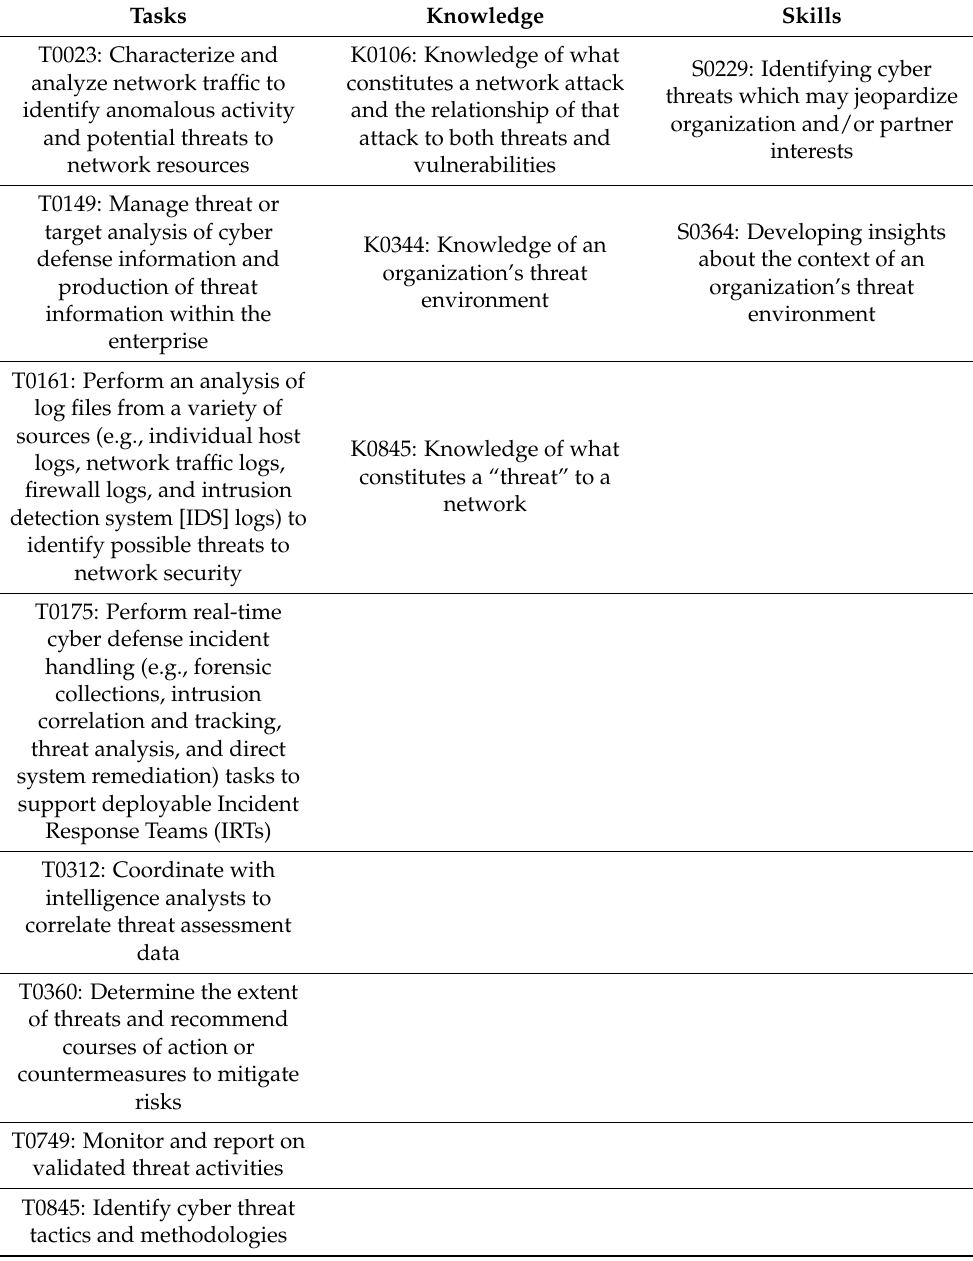
Table 3. KSTs for Threat Analyst work